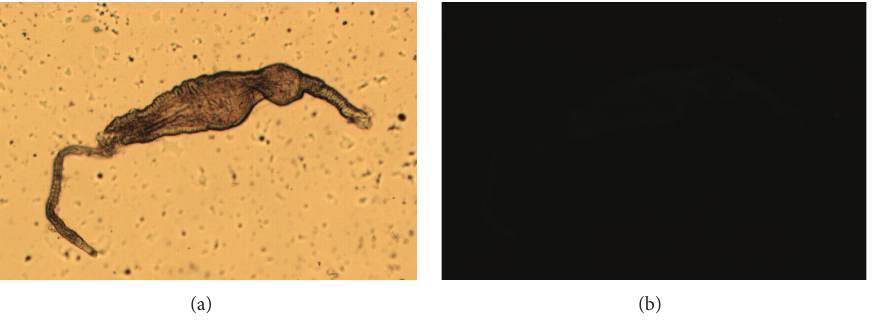
Figure 1: Bright field (a) and fluorescence (b) images of the control sample.